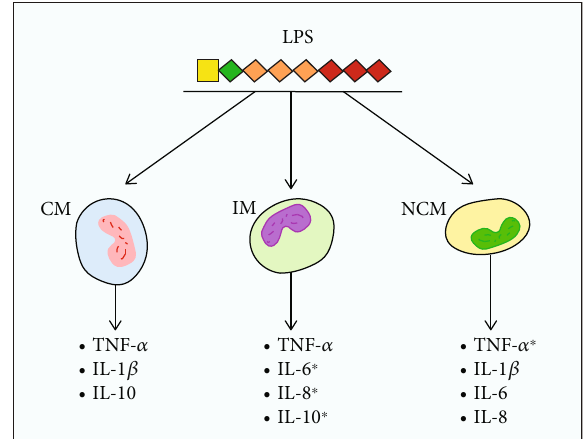
Figure 3: Expression of cytokines by subpopulations of monocytes after LPS activation. ∗ The cytokines expressed mainly by this subpopulation of monocytes. MP: myelomonocytic progenitor; CM: classical monocytes; IM: intermediate monocytes; NCM: nonclassical